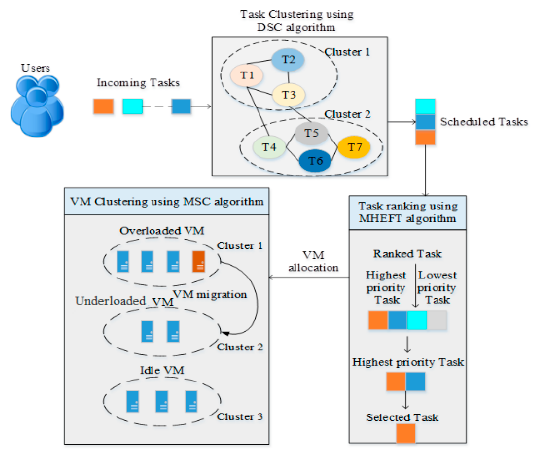
Figure 1. Architecture of the proposed work.